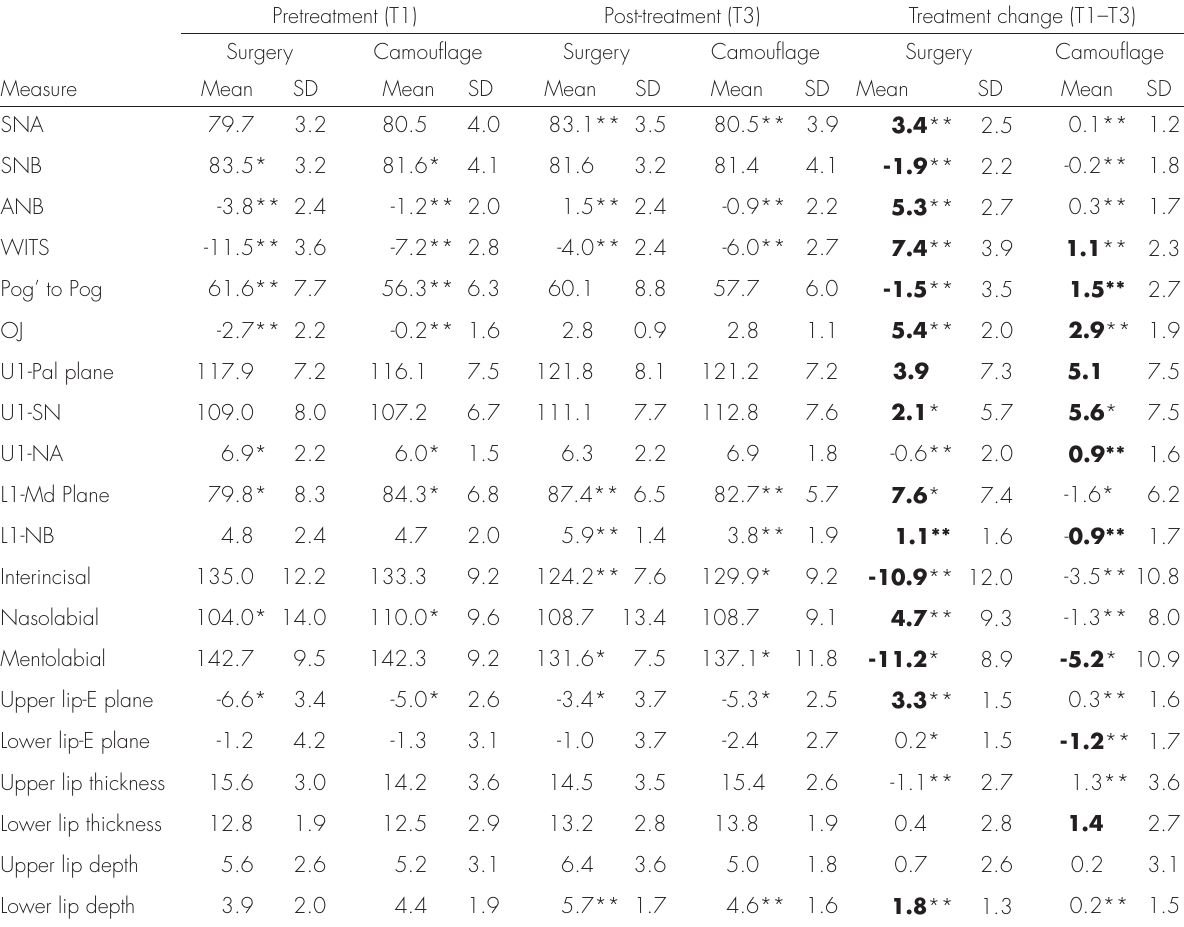
Table III. Cephalometric characteristics: surgery and camouflage groups.